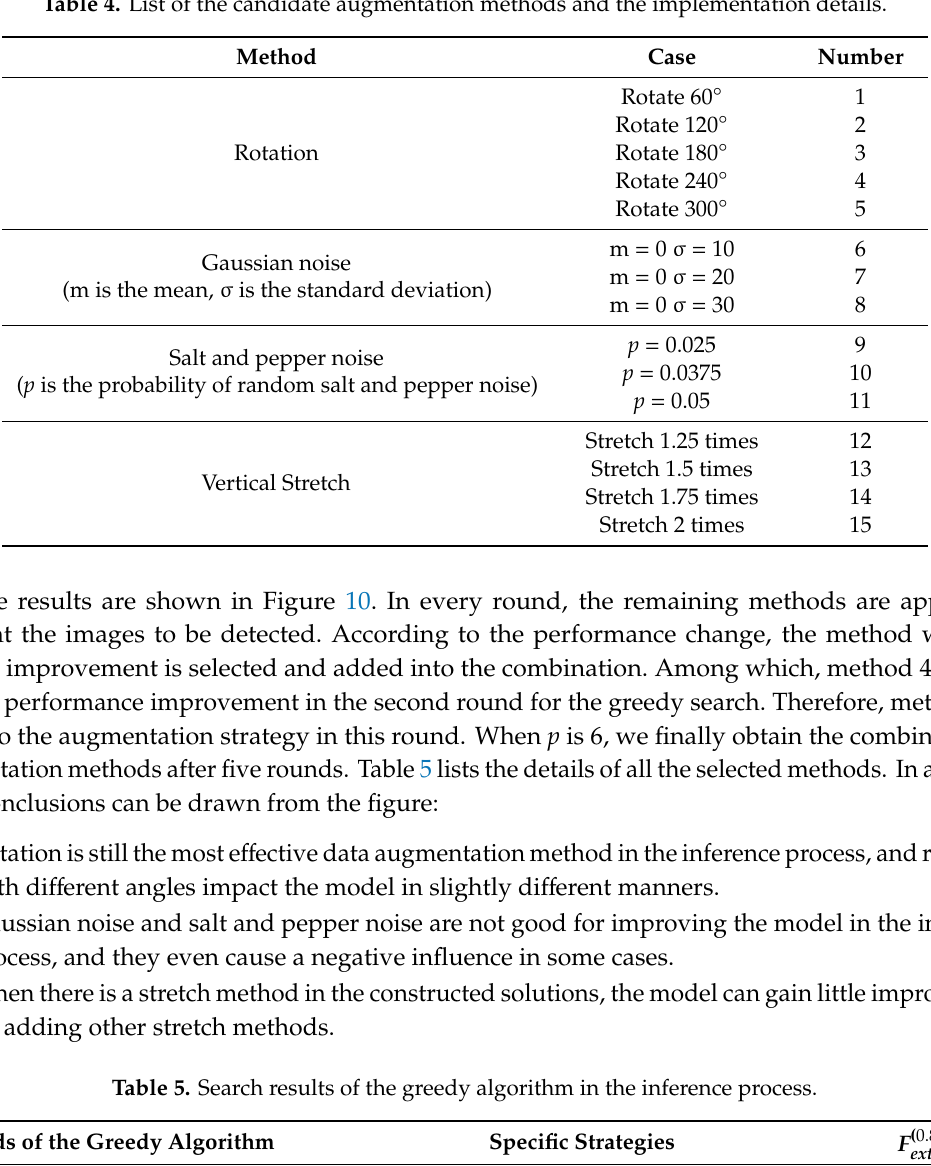
Table 4. List of the candidate augmentation methods and the implementation details.